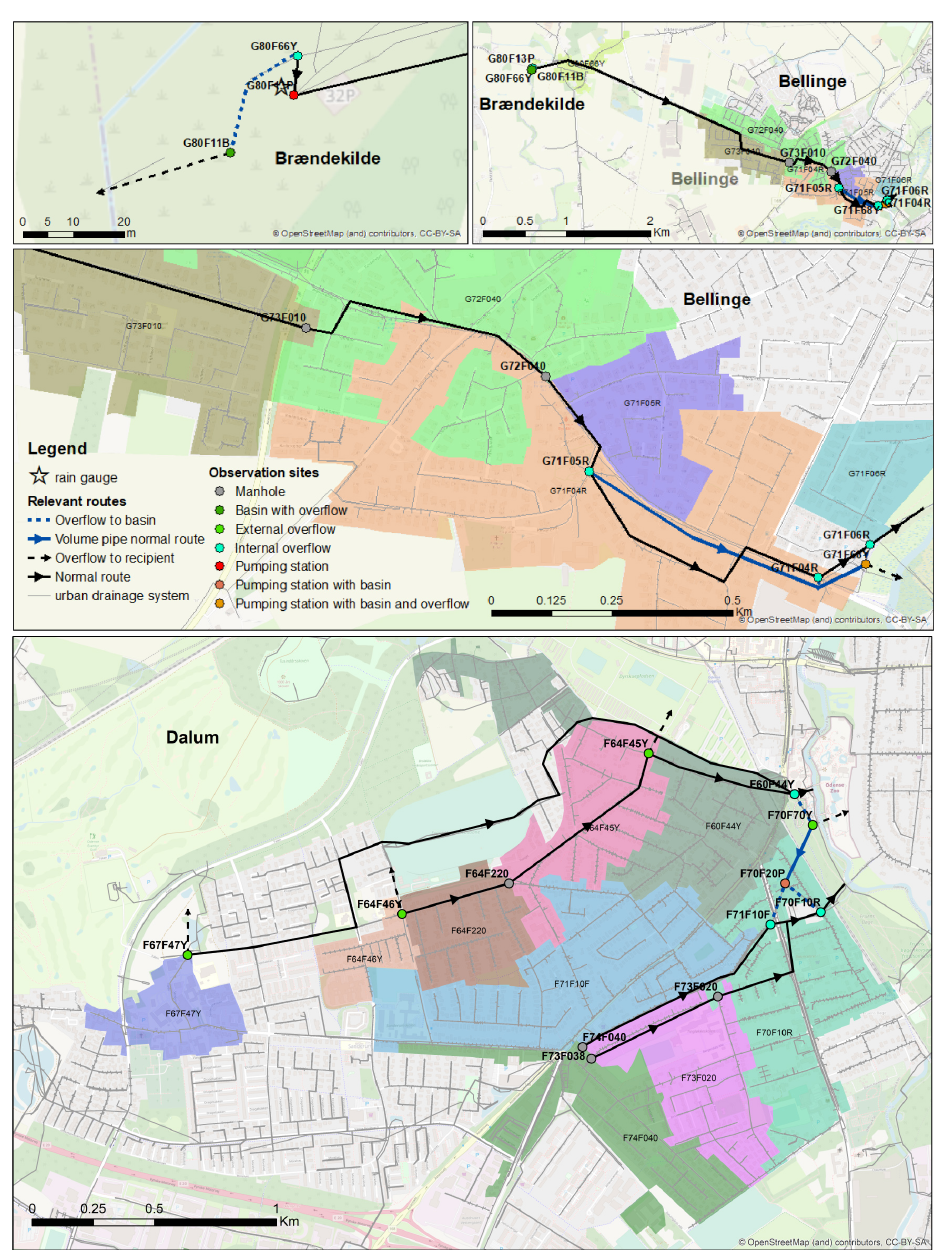
Figure 7. Observation sites in the case areas. Many internal connections between the different areas are present in Dalum, but these are not illustrated in the figure. The node names in the centre of the sub-catchments refer to the connected manholes downstream. The background map is from OpenStreetMap